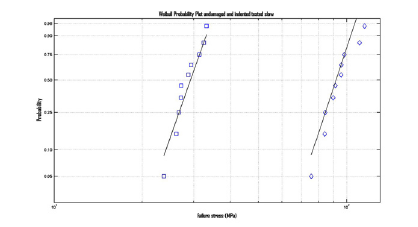
Figure 8: Weibull plot of fast test in water on normal and indented